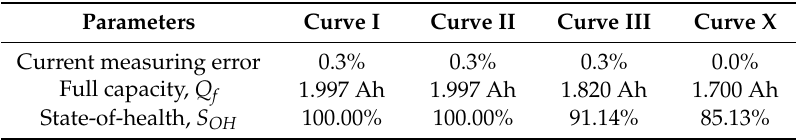
Table 2. Historic data of SOC estimation curves before the experimental